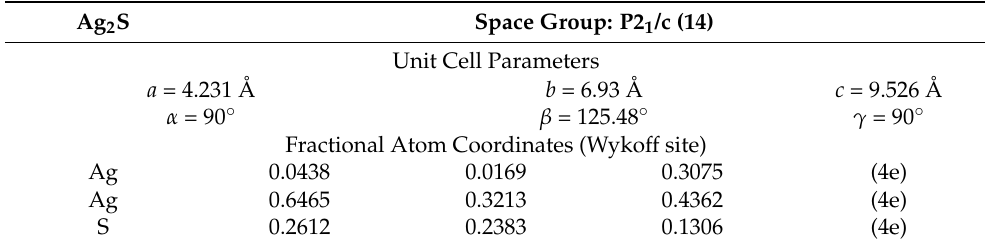
Figure 2. Crystal structure of acanthite Ag 2 S. Image generated using VESTA 3 [25]. Table 1. Crystal structure of acanthite Ag 2 S